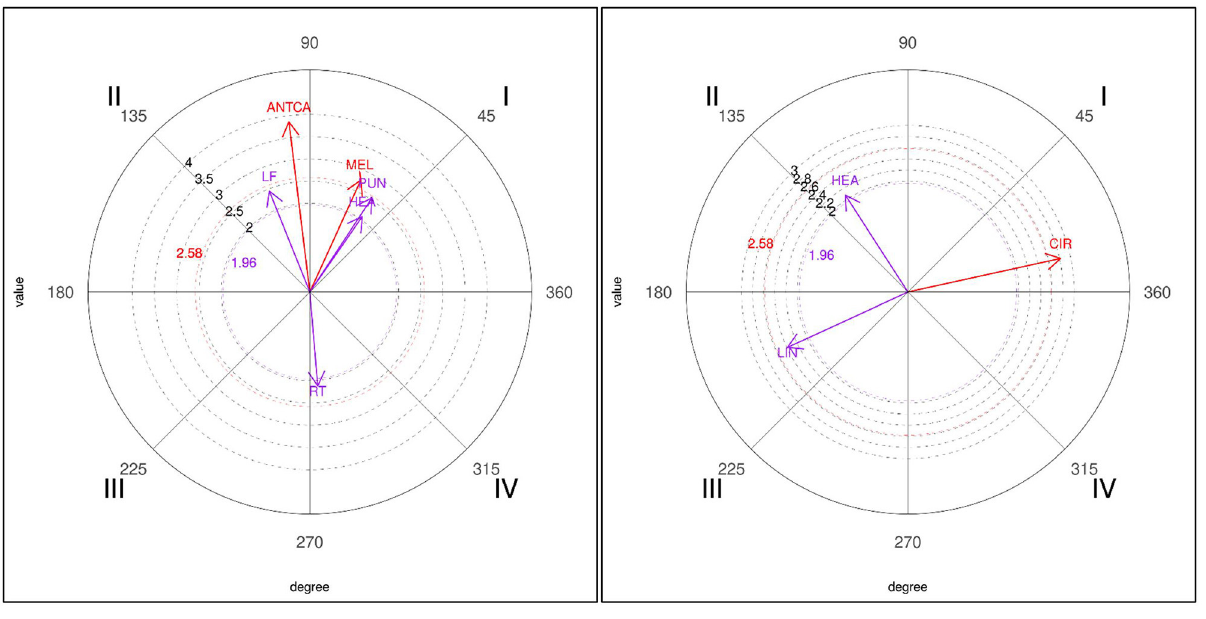
Frontiers in Sports and Active Living |